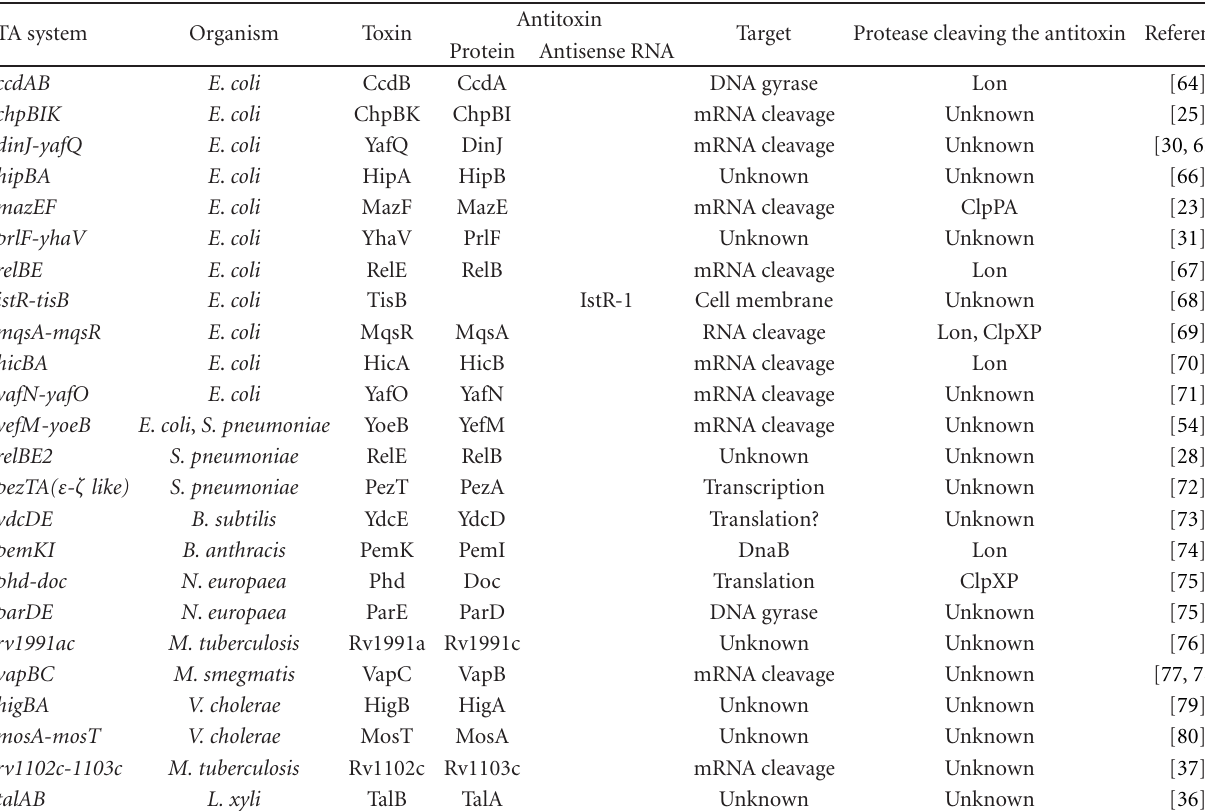
Table 2: Properties of TA systems in